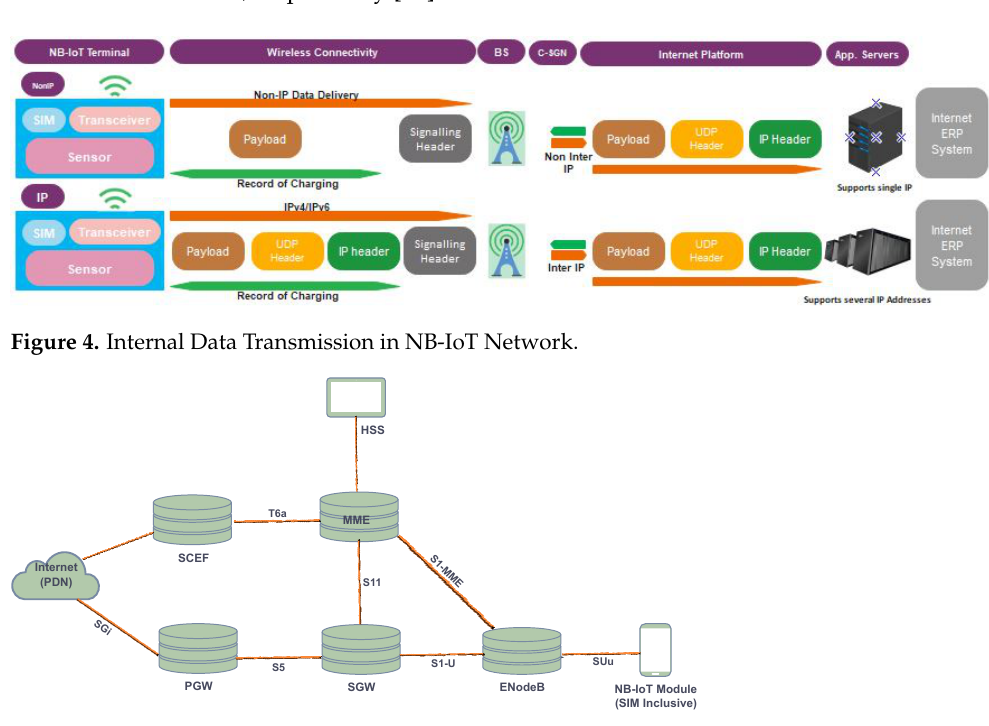
Figure 5. Evolve Packet Core (EPC) Architecture for Data Transmission between NB-IoT Terminals and the Internet using LTE